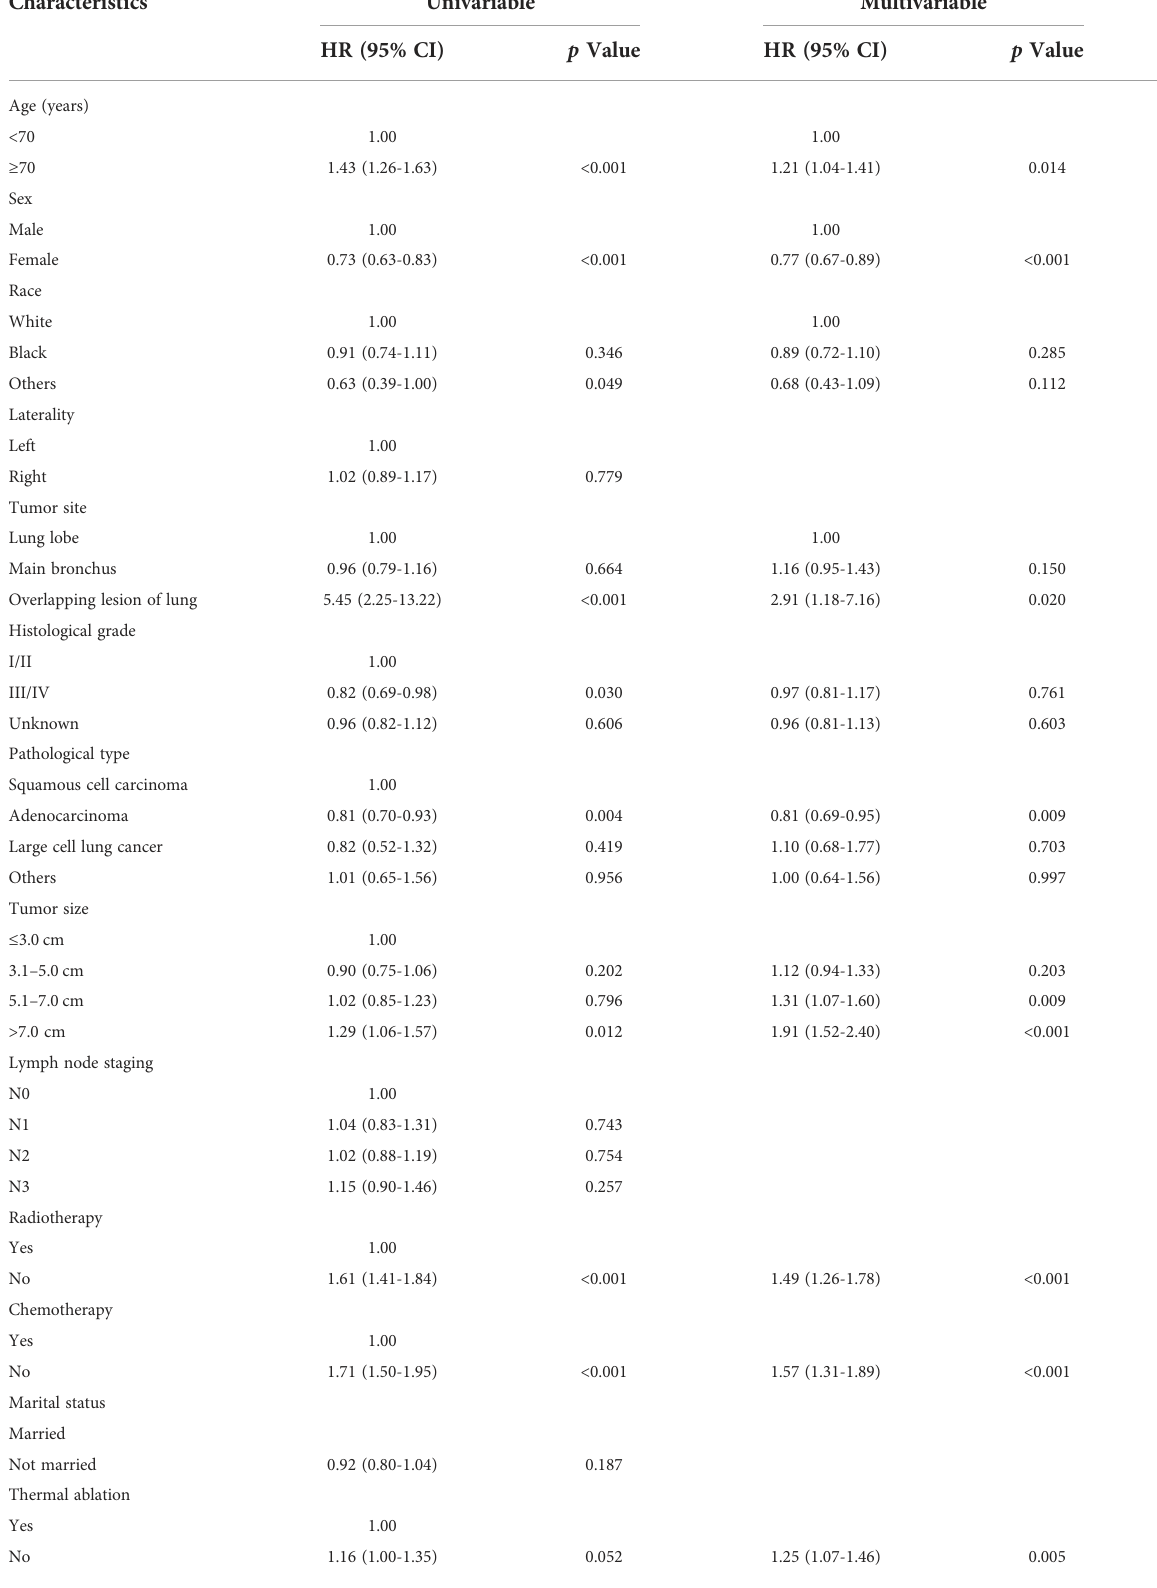
TABLE 2 Univariate and multivariate analyses of OS after